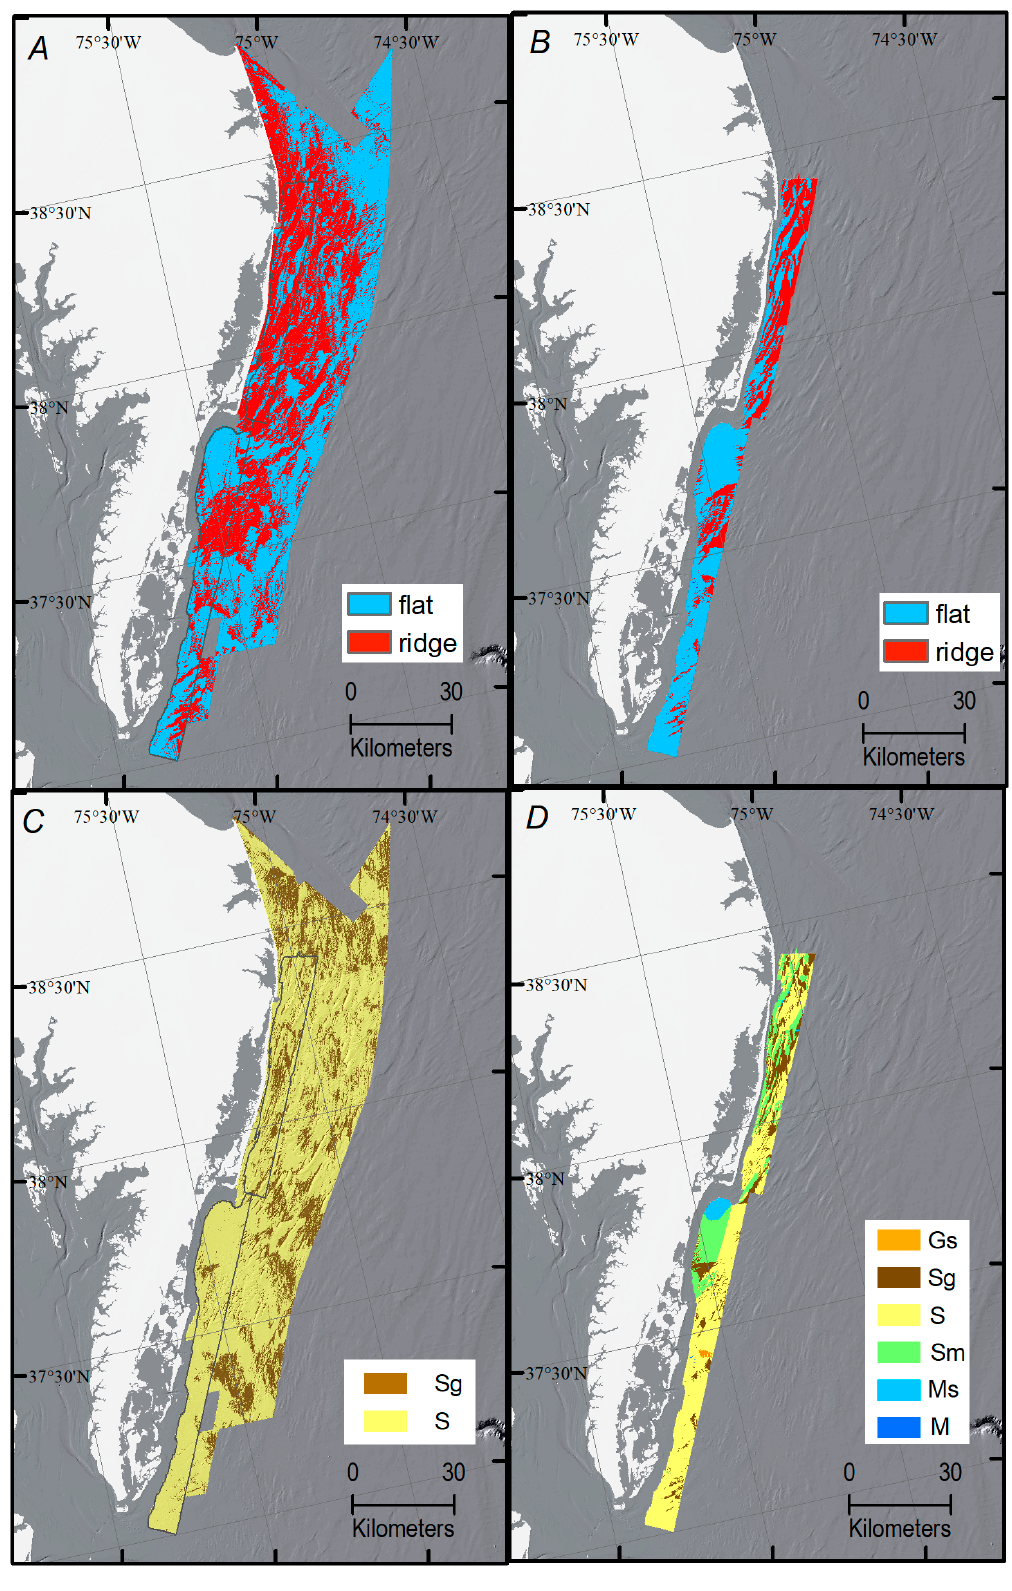
Figure 11. Sediment texture ( A , B ) and geomorphic ( C , D ) maps generated from machine-learning (this study, A , C ) and from manual digitization ([38], B , D ). Di ff erences observed in the sediment texture maps ( C , D ) are attributable to the scales of the studies and subjectivity and flexibility that inherently exists in manual classifications.